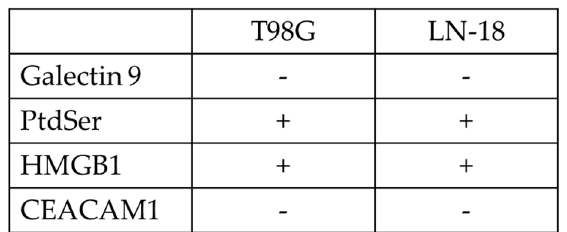
Figure 2. Expression of the TIM3 ligands Galectin 9, Phosphatidylserine, HMGB1 and CEACAM1 in the T98G and LN-18 glioma cell lines. Data were obtained from the Affymetrix Human Genome U133 Plus 2.0 Array (National Center for Biotechnology Information Gene Expression Omnibus database, accession no. GSE23806). Affymetrix Microarray Suite 5.0 was used to generate signal values and detection calls: absent (-) or present (+).